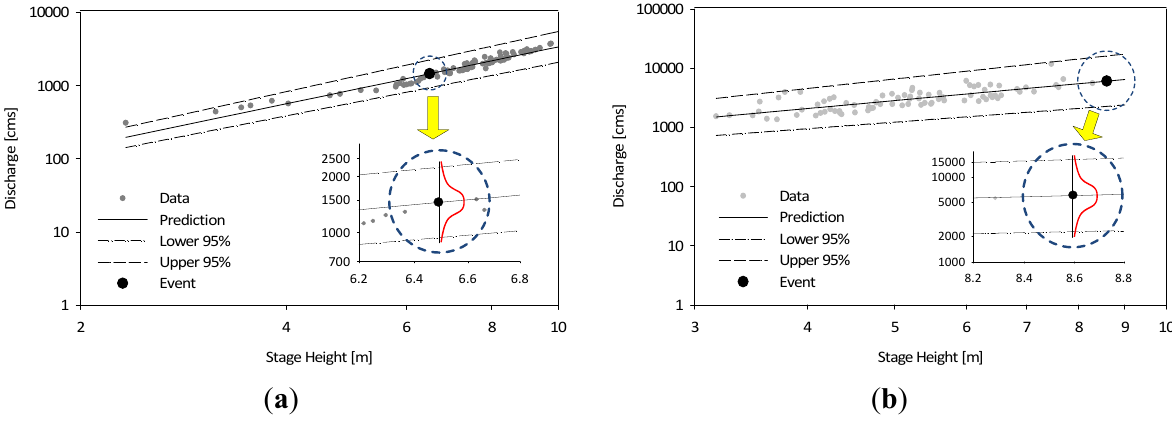
Figure 8. Stage-discharge rating curve based on peak flows provided by USGS. ( a ) Montezuma reach; ( b ) Nebraska reach.